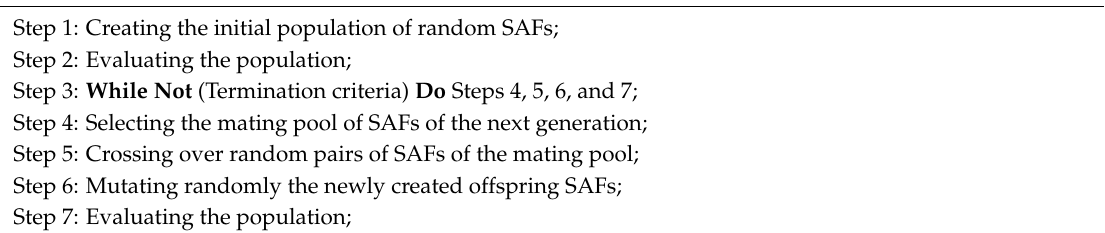
Algorithm 1. The main algorithmic steps of the GP algorithm.